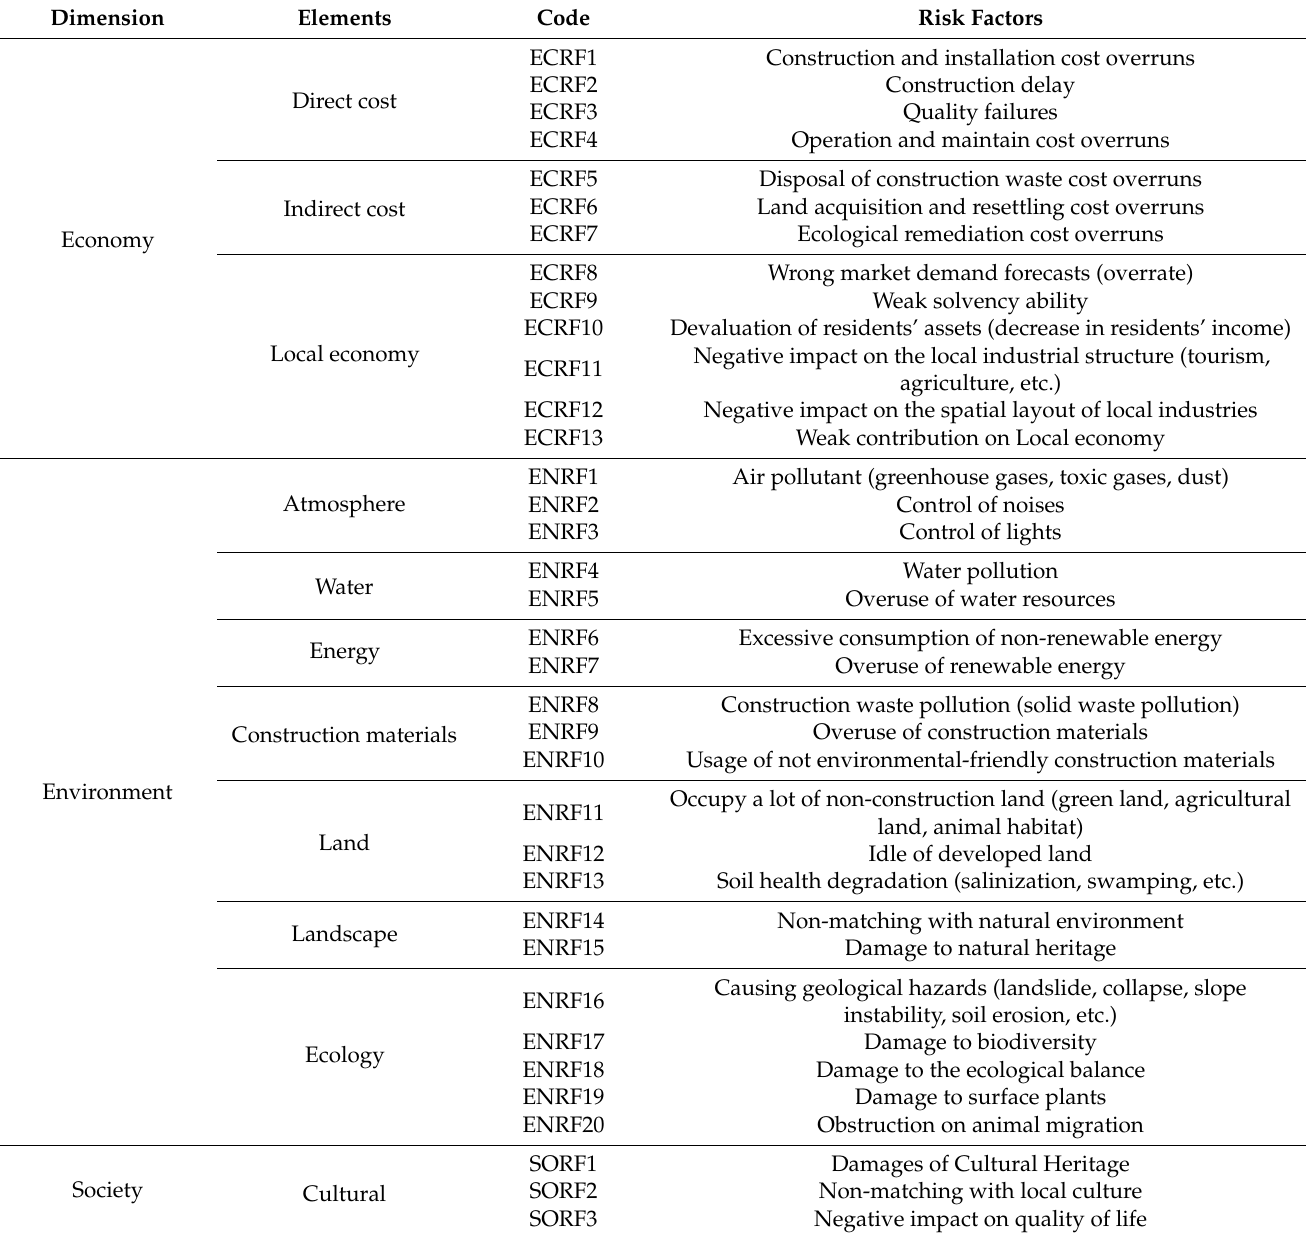
Table 4. The risk factors of mega infrastructure projects